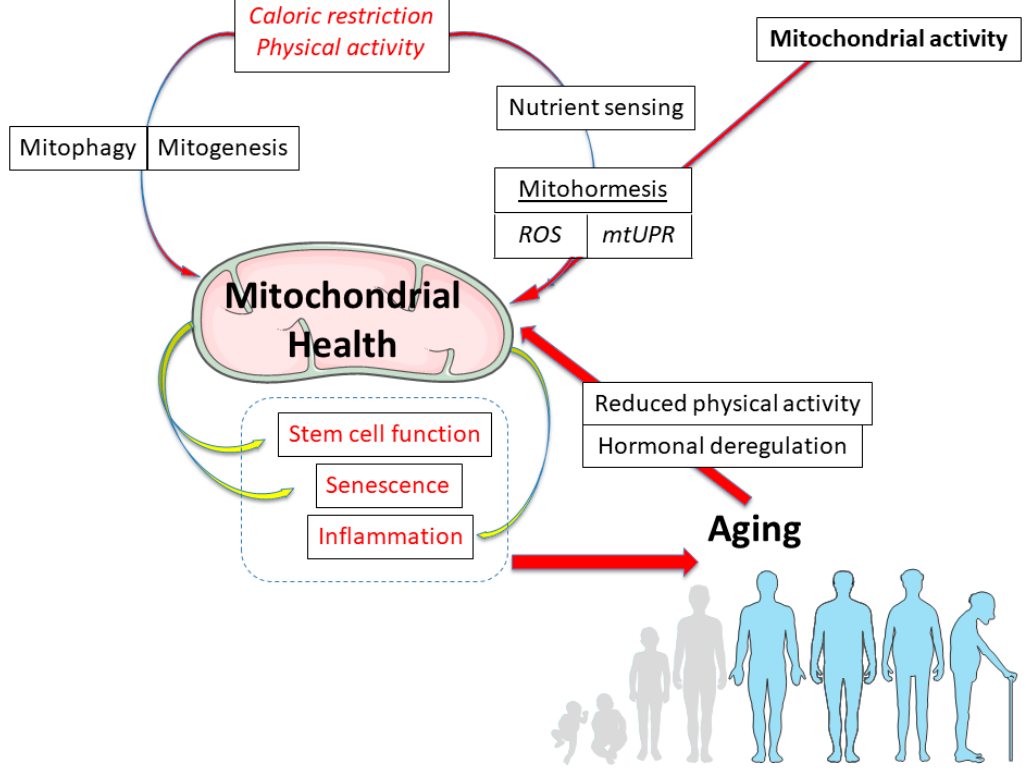
Figure 1. Mitochondrial Health at the center of a Cause–Consequence cell crossroad. The original, simplistic view of the Mitochondrial Free Radical Theory of Aging (MFRTA), postulating a mitochondrial activity/ROS/mtDNA isolated interaction, was progressively replaced by a more integrative view in which healthy mitochondria are the result of multiple cellular pathways and activities, impacting different aspects of aging, in diverse tissues and in different manners. See text for details.